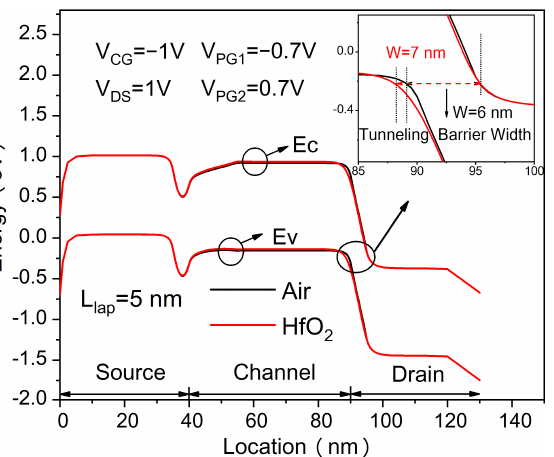
Figure 7. Transfer characteristics of proposed in-built N + pocket ED-TFET with an ED drain for different spacer materials at the drain side.